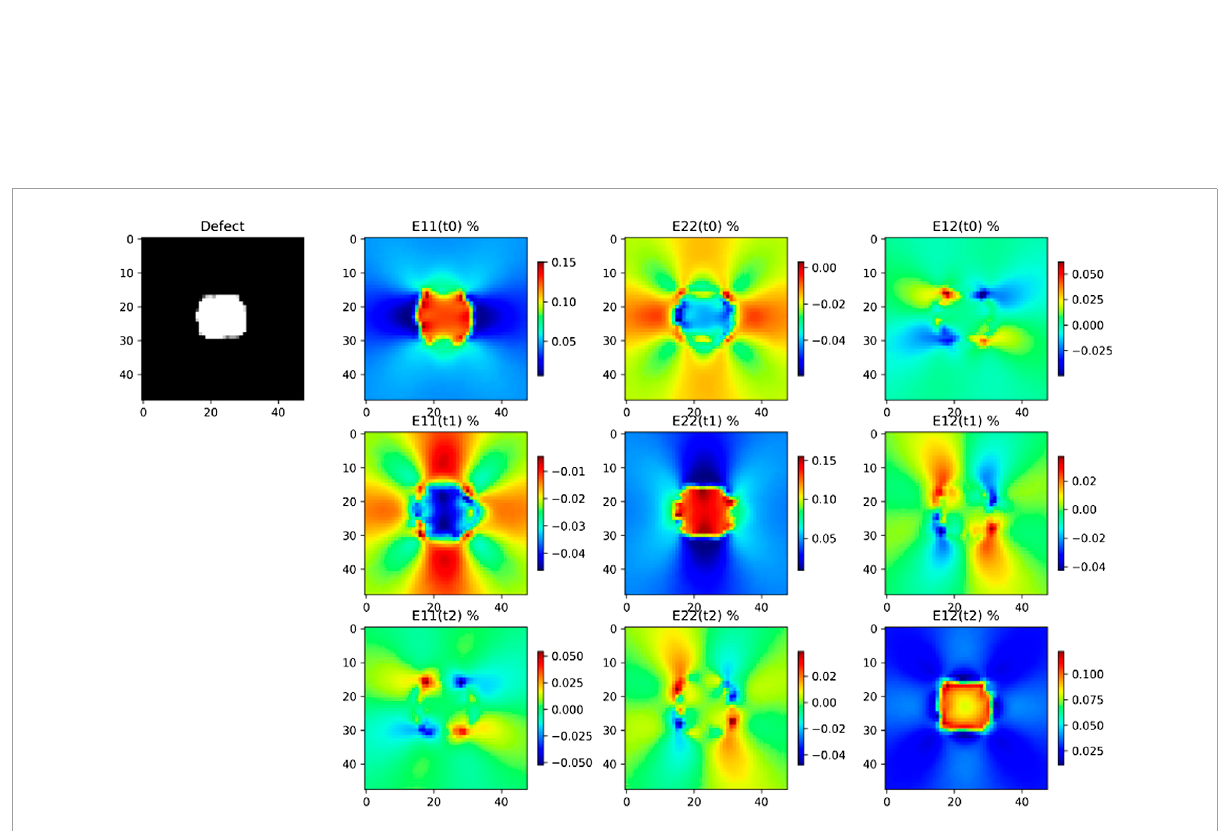
FIGURE 4 Multimodal data for digital twin i = 2, on the top left μ ( 2 ) □ ; on the right, the 3 components of the strain tensor ɛ ( u (2) ) at 3 time instants t 0, t 1, t 2.